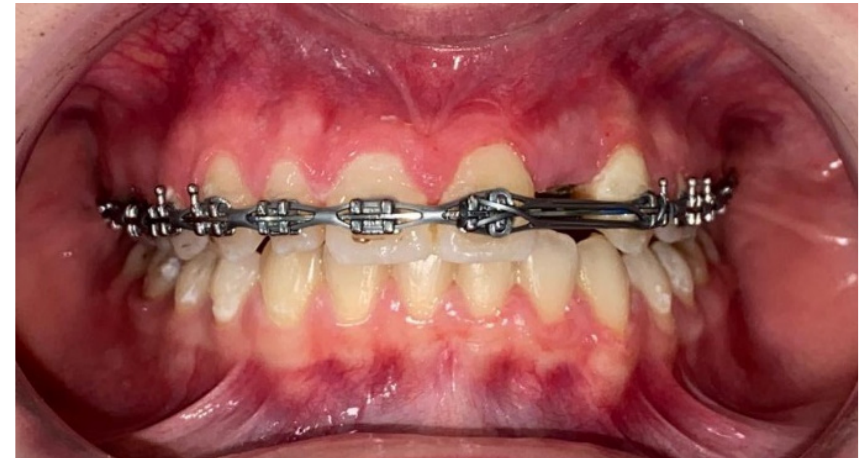
Figure 3. Patient wearing fixed orthodontic appliances. The accumulation of dental plaque can be observed along the gingival line and around the orthodontic appliances.